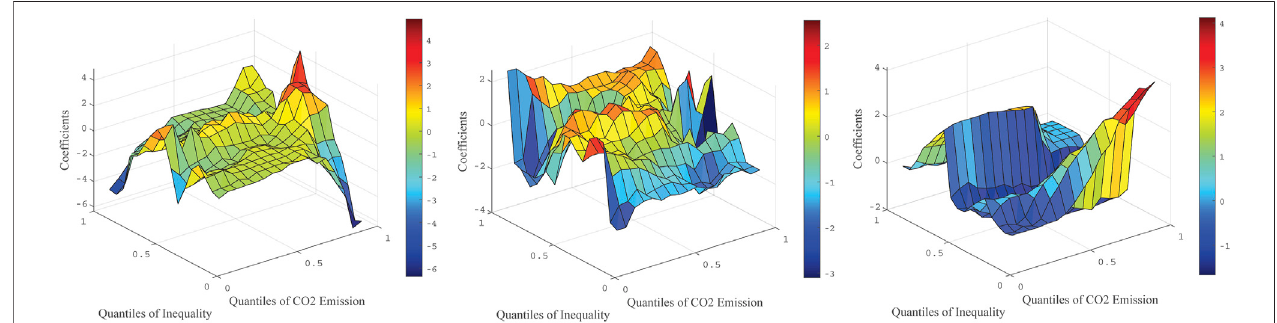
FIGURE 6 | The impact of income inequality on carbon emissions in the short, medium and long term (U.S.).